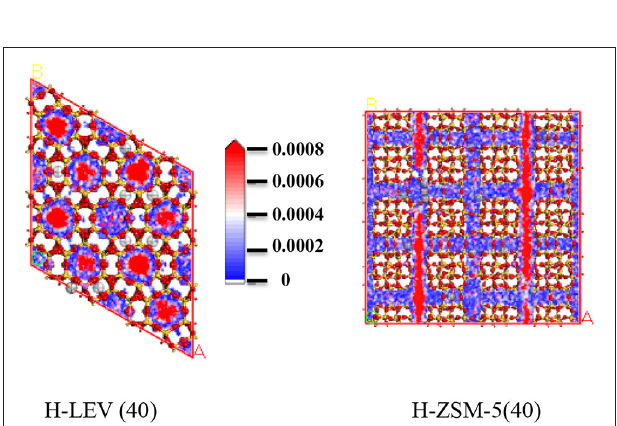
FIGURE 9 | Density distribution of propylene in H-ZSM-5 (40) and H-LEV (40) under 680K, 100 kPa.